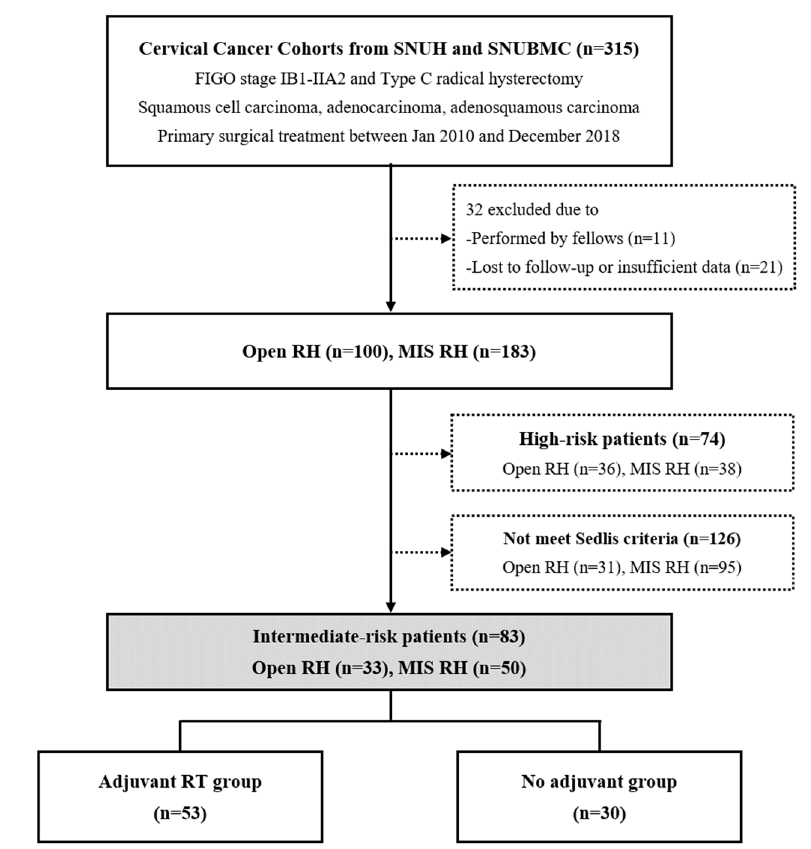
Figure 1. Flow diagrams depicting selection of the study population.